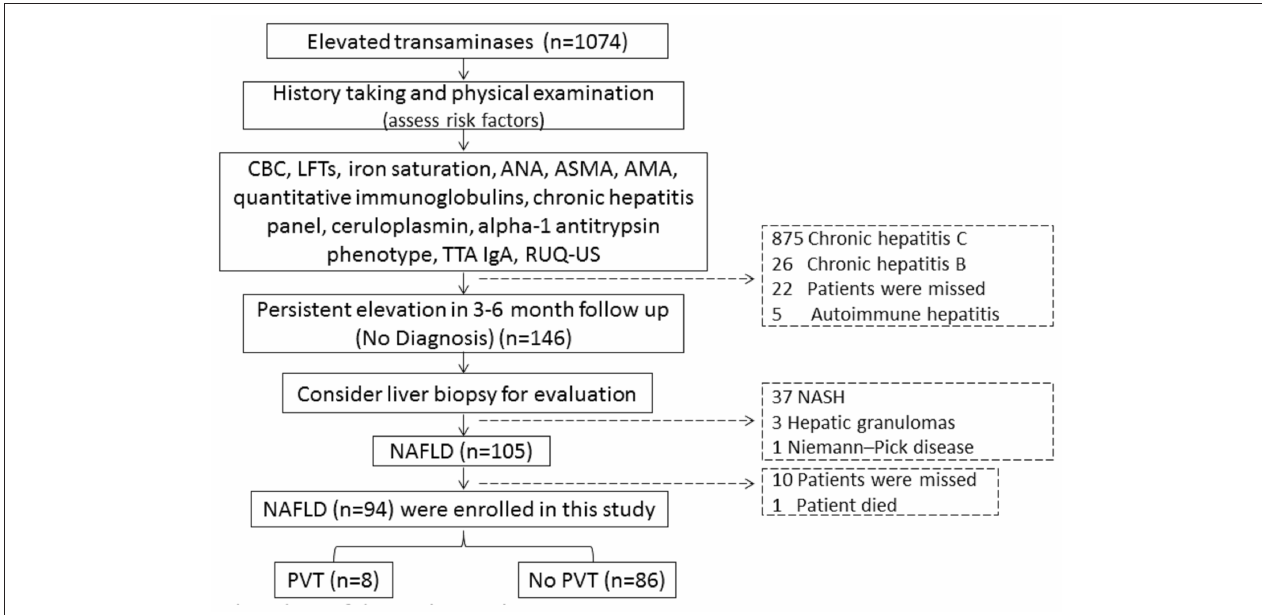
FIGURE 1 | Flow chart of the study population. CBC, complete blood picture; LFTs, liver function tests, ANA, antinuclear antibody; ASMA, anti-smooth muscle antibody; AMA, antimitochondrial antibodies; TTA lgA, tissue transglutaminase lgA; RUQ-US, right upper quadrant abdominal-ultrasonography; NASH, non-alcoholic steatohepatitis; NAFLD, non-alcoholic fatty liver diseases; PVT, portal vein